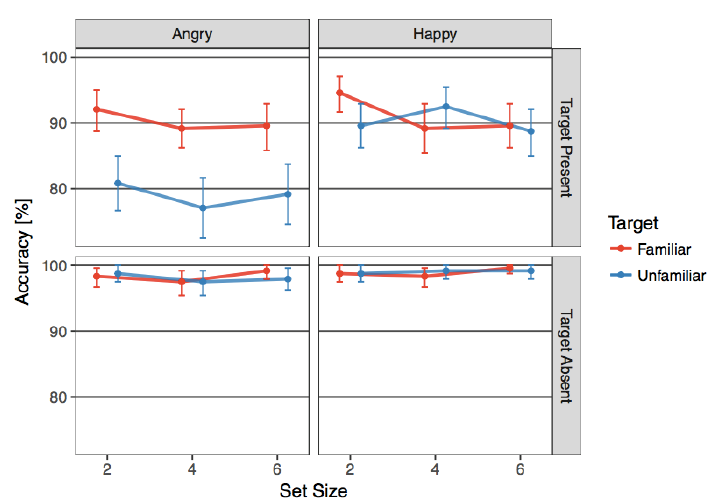
Figure 2. Accuracy in reporting presence or absence of target expression as a function of set size of images. Rows depict target present or absent condition and columns depict the target expression for the block. The effect of familiarity on accuracy is driven by greater accuracy for familiar faces when the target is present, and the target expression is angry. Error bars indicate 95% bootstrapped confidence